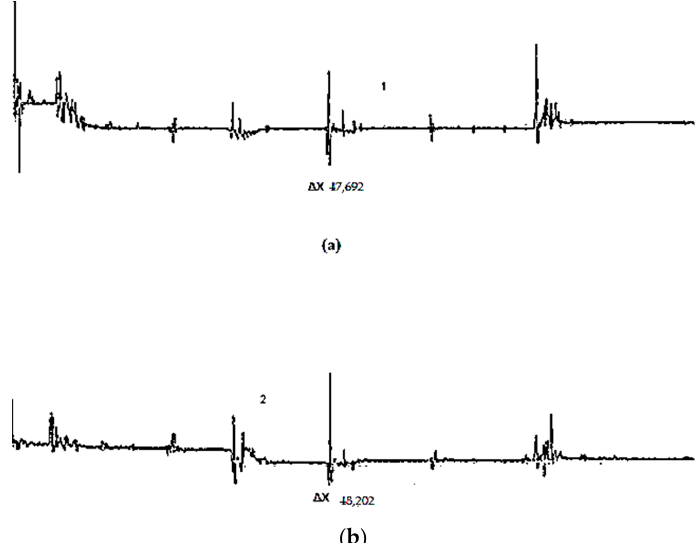
Figure 23. Comparison of periods of acceleration in a test. Note: 1—graduated arc, and 2—main roller axis. Note: ( a ) the acceleration of the main roller in the graduated arc, ( b ) the acceleration of the main roller in the pushing stage.